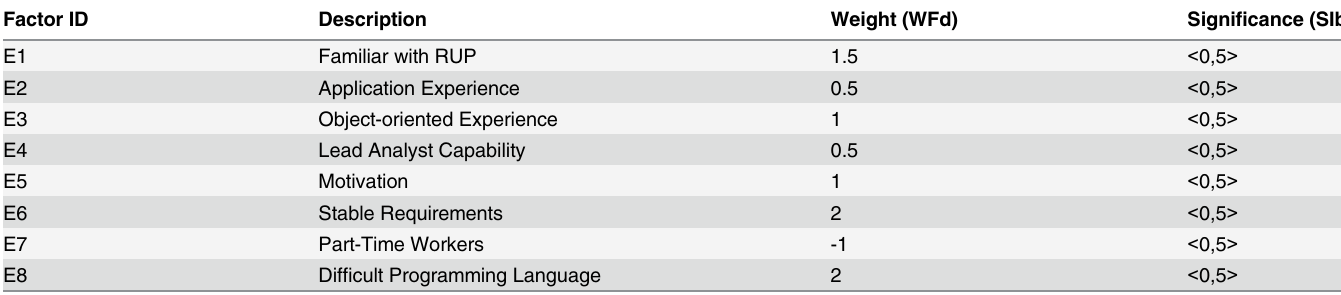
Table 4. Environmental